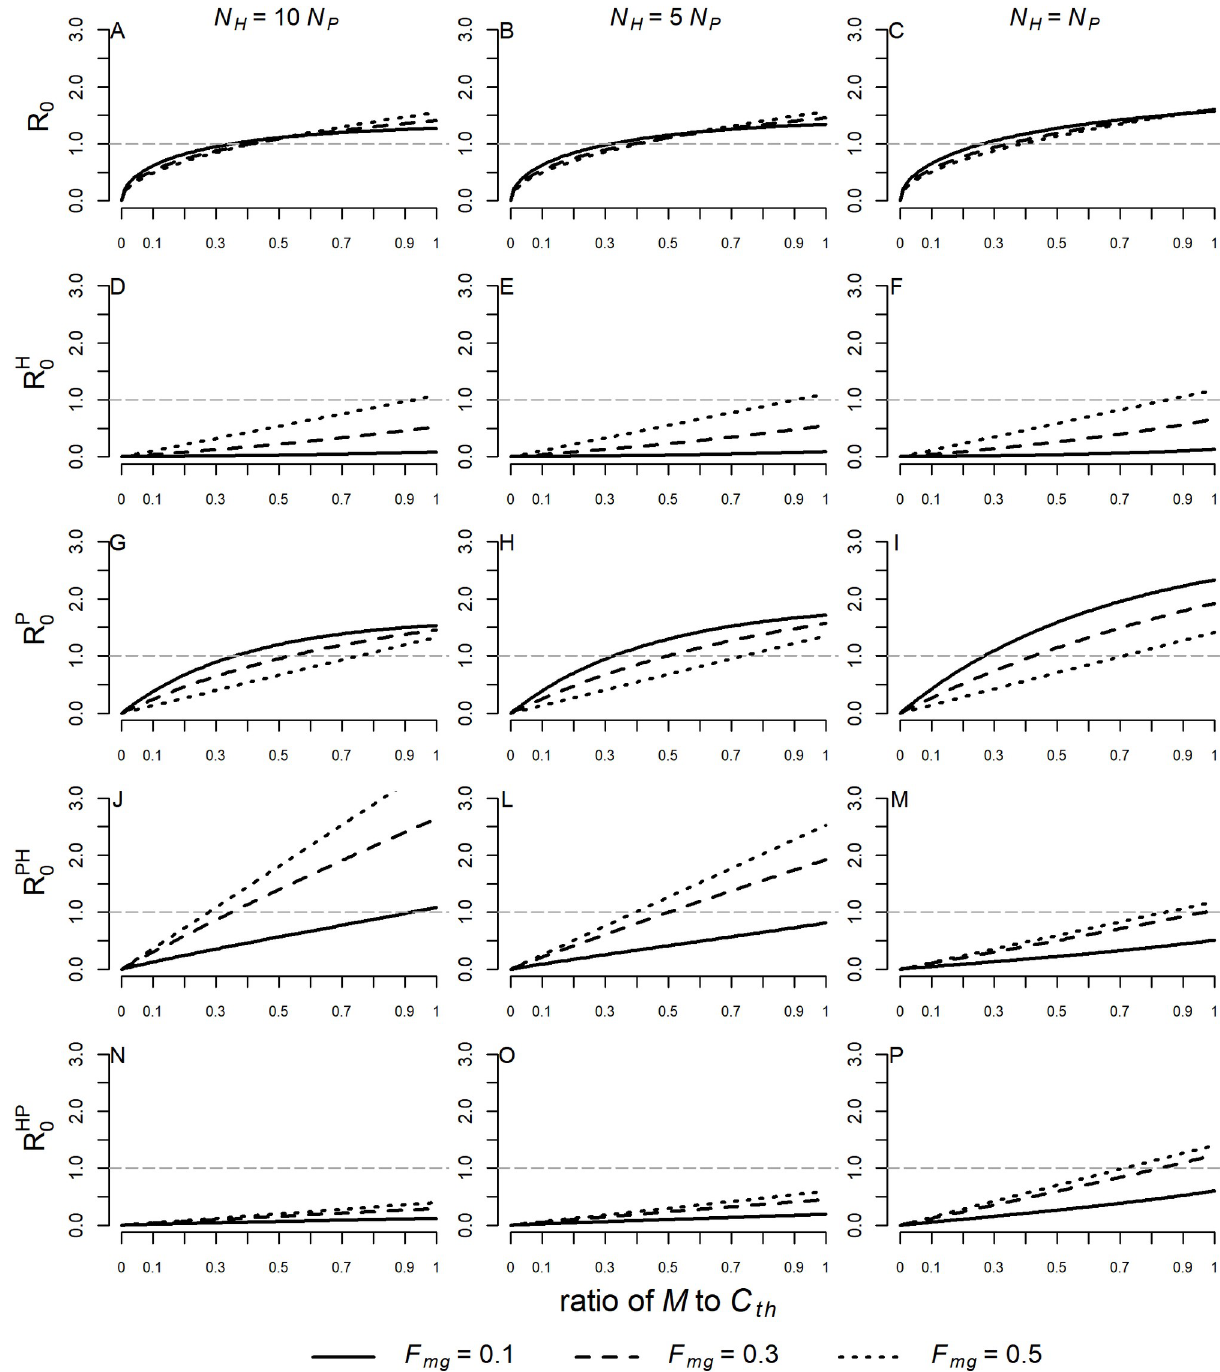
Fig 3. Variations in R 0 , R H ; R P ; R PH and R HP with the ratio of M to C and F (or 1 − F ). The dashed line represents the epidemic threshold, above th mg mc 0 0 0 0 which more than one new case will be generated in the susceptible population by an infected individual. Values were simulated for ratios of M to C th ranging from 0.01 to 0.99 and for F = 0.1, 0.3, and 0.5. Three different scenarios were considered: N = 10 N (A, D, G, J, N), N = 5 N (B, E, H. L, O) mg H P H P and N H = N P (C, F, I, M, P). The following values were assumed to simian parameters: τ = 0.0044, T MP = 0.034, and T PM = 0.428 when N H = 10 N P ; τ = 0.0044, T = 0.029, and T = 0.342 when N = 5 N ; τ = 0.0038, T = 0.026, and T = 0.261 when N = N . The values of the other parameters were MP PM H P MP PM H P fixed: C th = 20( N H + N P ), C ¼ ð C (cid:0) M Þ 1 ; C g = C c , μ = 0.8, γ = 0.0035, T MH = 0.022, T MP = 0.044, T HM = 0.24, b = 0.5, h = 20, B c = 0 and B g = c th 2